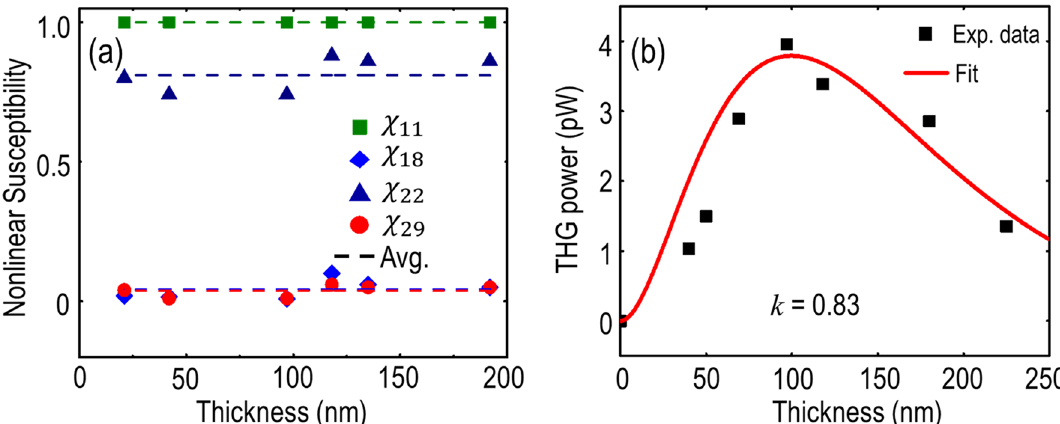
Figure 4. ( a ) Extracted relative magnitudes of χ 11 , χ 18 , χ 22 and χ 29 with respect to the flake thickness, plotted as green squares, blue rectangles, royal blue upper triangles and red circles, respectively. The average values are marked as dashed lines with the associated colors. ( b ) Dependence of the THG emission power on the franckeite flake thickness. Experimental data and theoretical fitting are plotted with black squares and red solid curve,